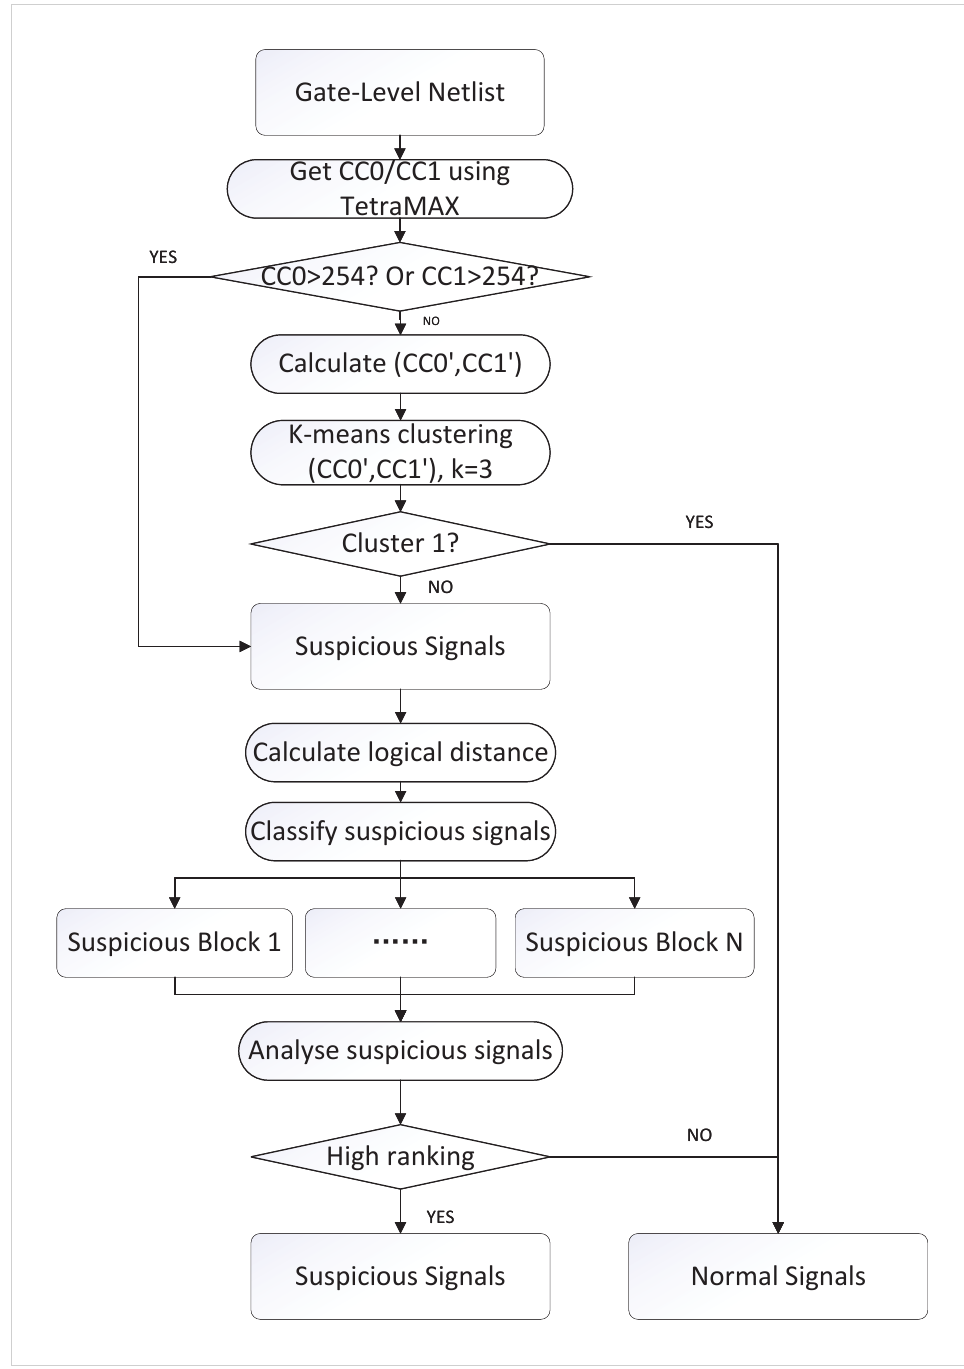
Figure 4. Complete test flow